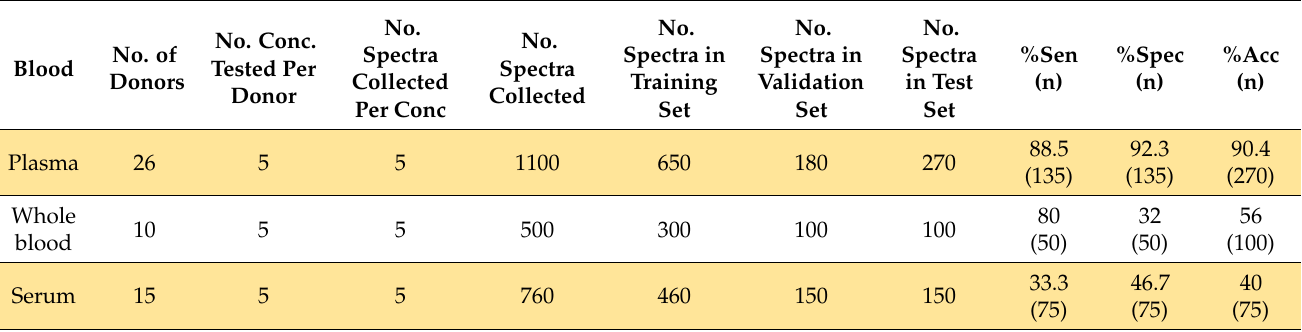
Table 2. A summary of number of donors, NIR spectra collected, distribution of samples in the training, validation, and test sets of neural models, and the sensitivity, specificity, and accuracy of the test set.